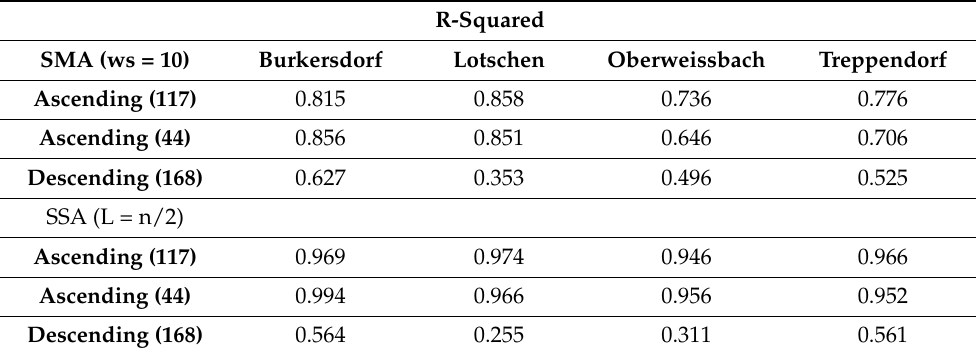
Table 3. Correlation coefficient (R 2 ) of in-situ evapotranspiration and cross-polarized (VH) Sentinel 1 backscatter for each AOI and both ascending and descending Sentinel-1 acquisitions. All datasets were filtered with SMA (top) and SSA (bottom)